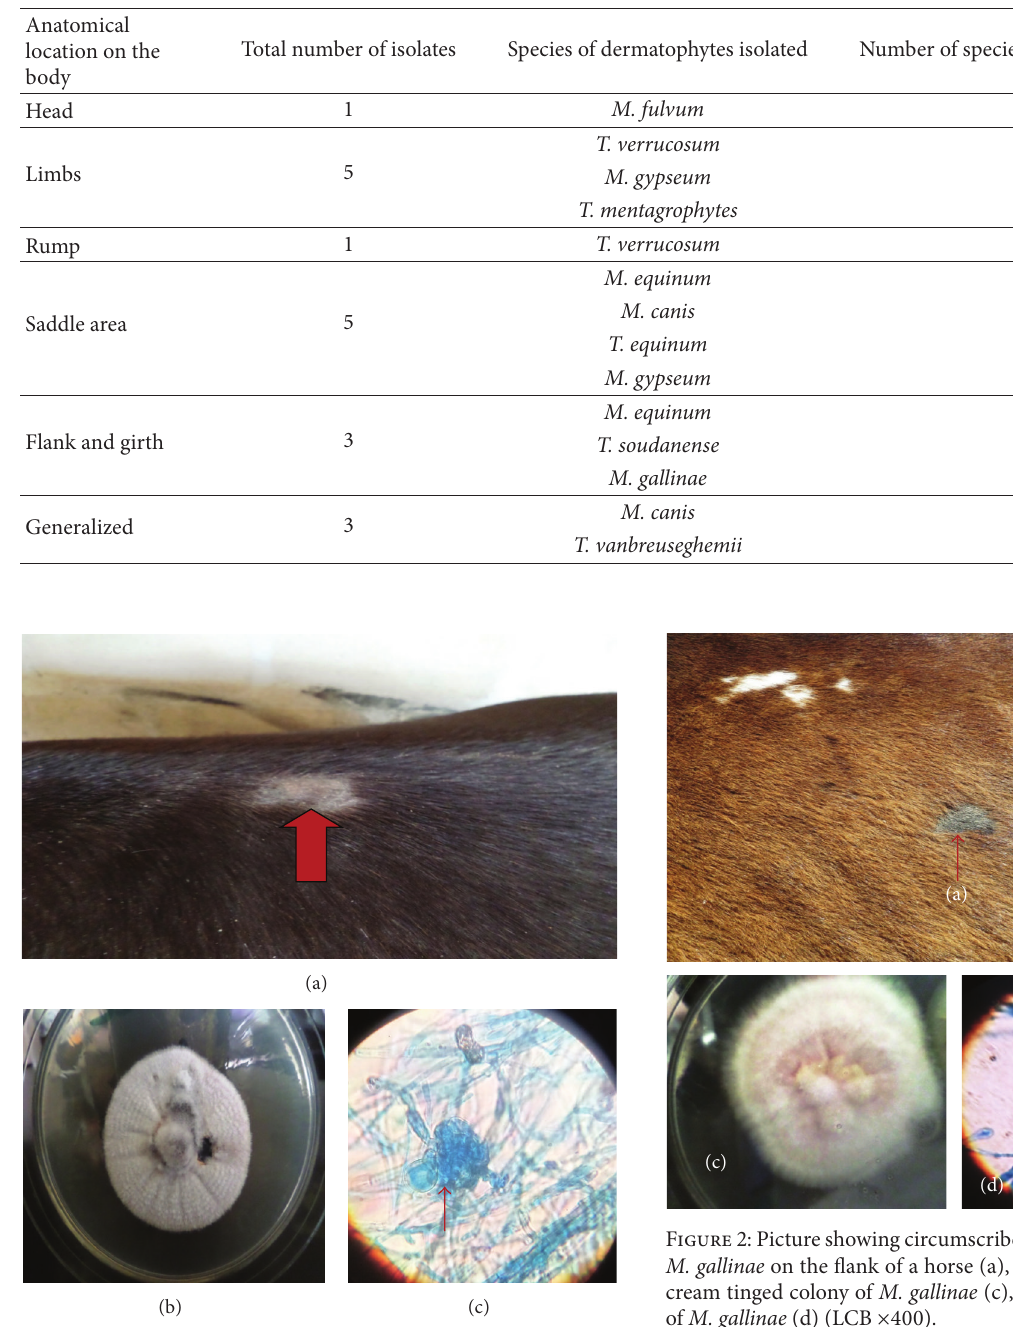
Table 2: Species distribution of dermatophytes isolated from different anatomical sites of horses with cutaneous skin lesions in Kaduna State, Nigeria.